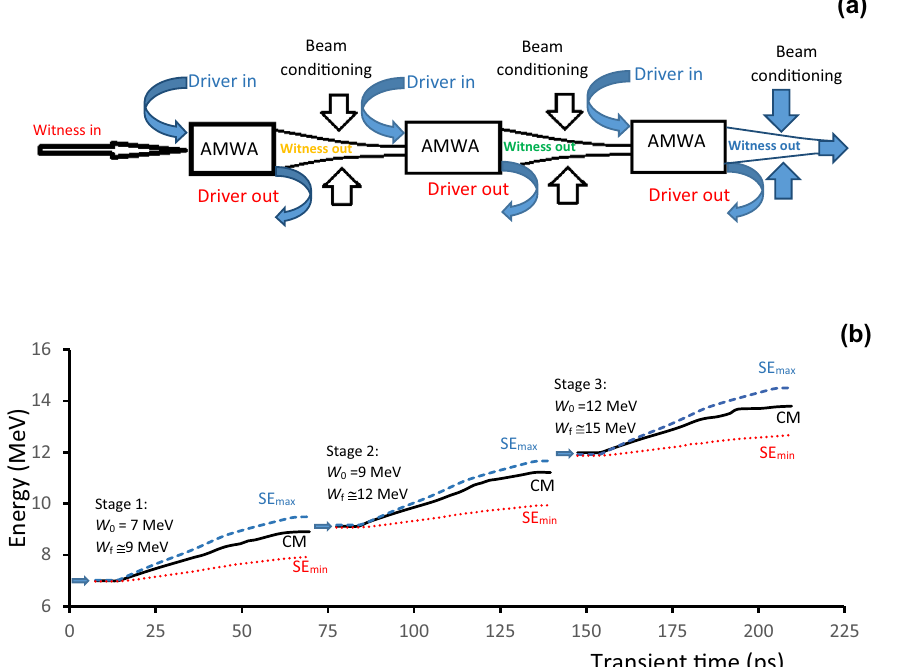
FIG. 5. (a) Schematic illustration of the AMWA cascade accelerator. (b) Results of numerical simulations using 3D PiC code MAGIC . An example of acceleration of the witness bunch from 7 MeV (CM) to above 14 MeV (CM) in three stages. Figure 5(b)is to illustrate two main challenges in the realization of the AMWA cascade accelerator concept: driver depletion (needs for three sections) and witness bunch energy spread at the exit of the AMWA section. The dependences of the WB energies on the bunch transient time in stages are — maximum energy), solid line (CM), dotted line (SE — minimum shown by the top dashed line (SE max min